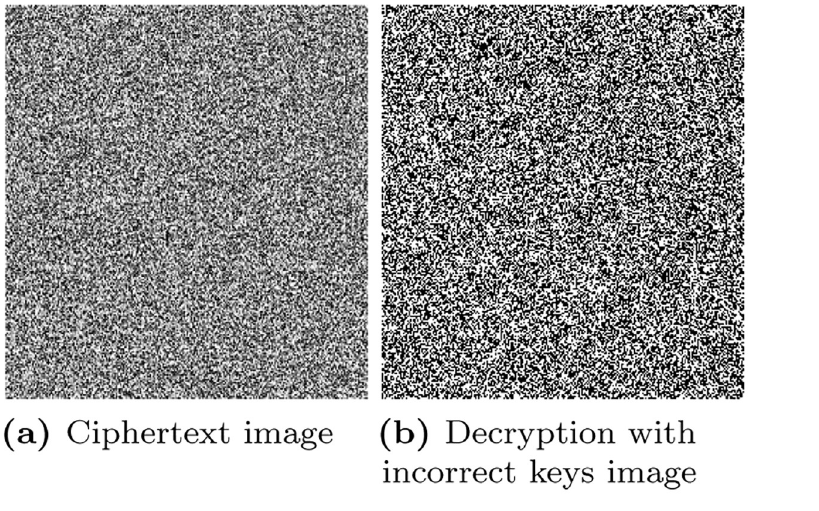
Fig 12. Key sensitivity analysis.